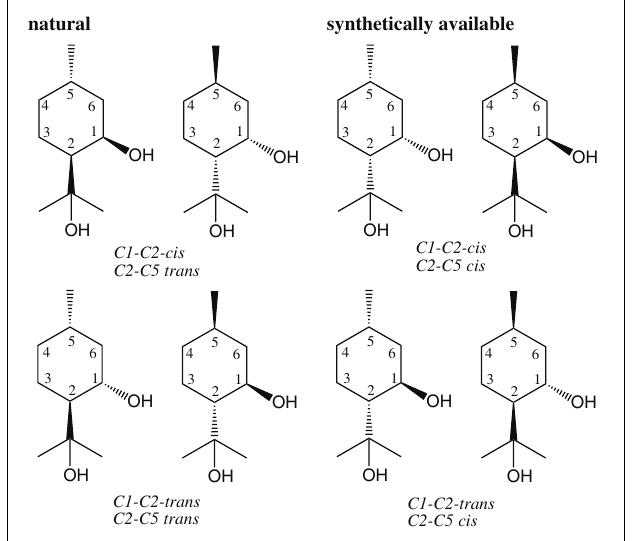
FIGURE 6 | Natural and synthetically available structures of stereoisomers of PMD.